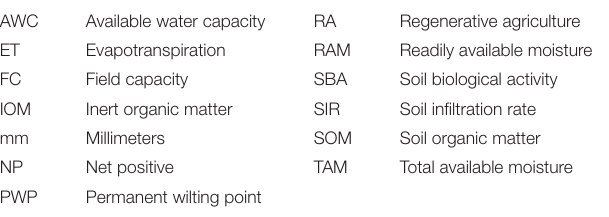
TABLE 1 | List of